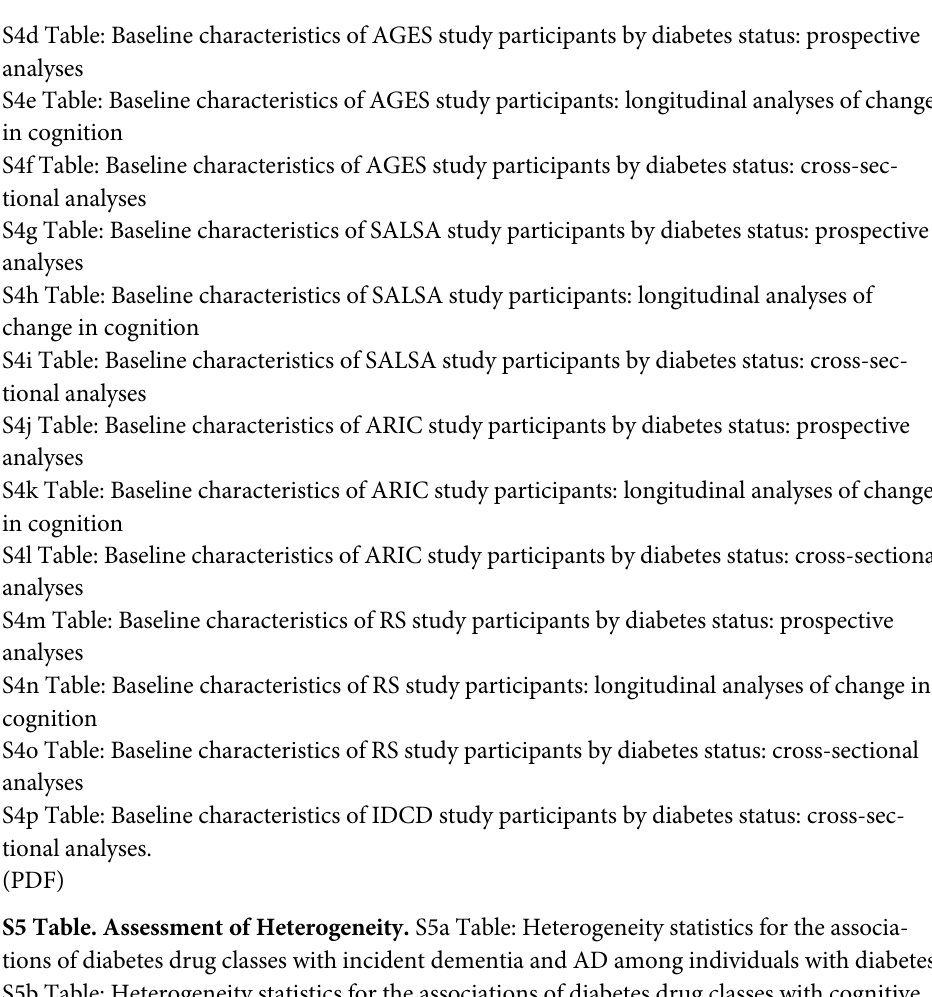
performance among individuals with diabetes change among individuals with diabetes measures among individuals with